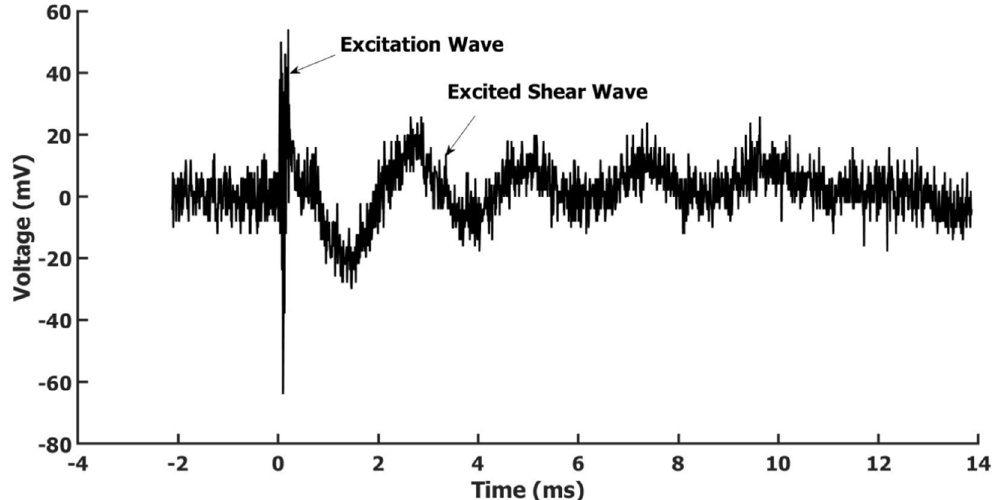
Figure 7. The excited shear wave on a nylon membrane by the air-coupled focused PZT transducer and measured by the fiber optic Sagnac system.